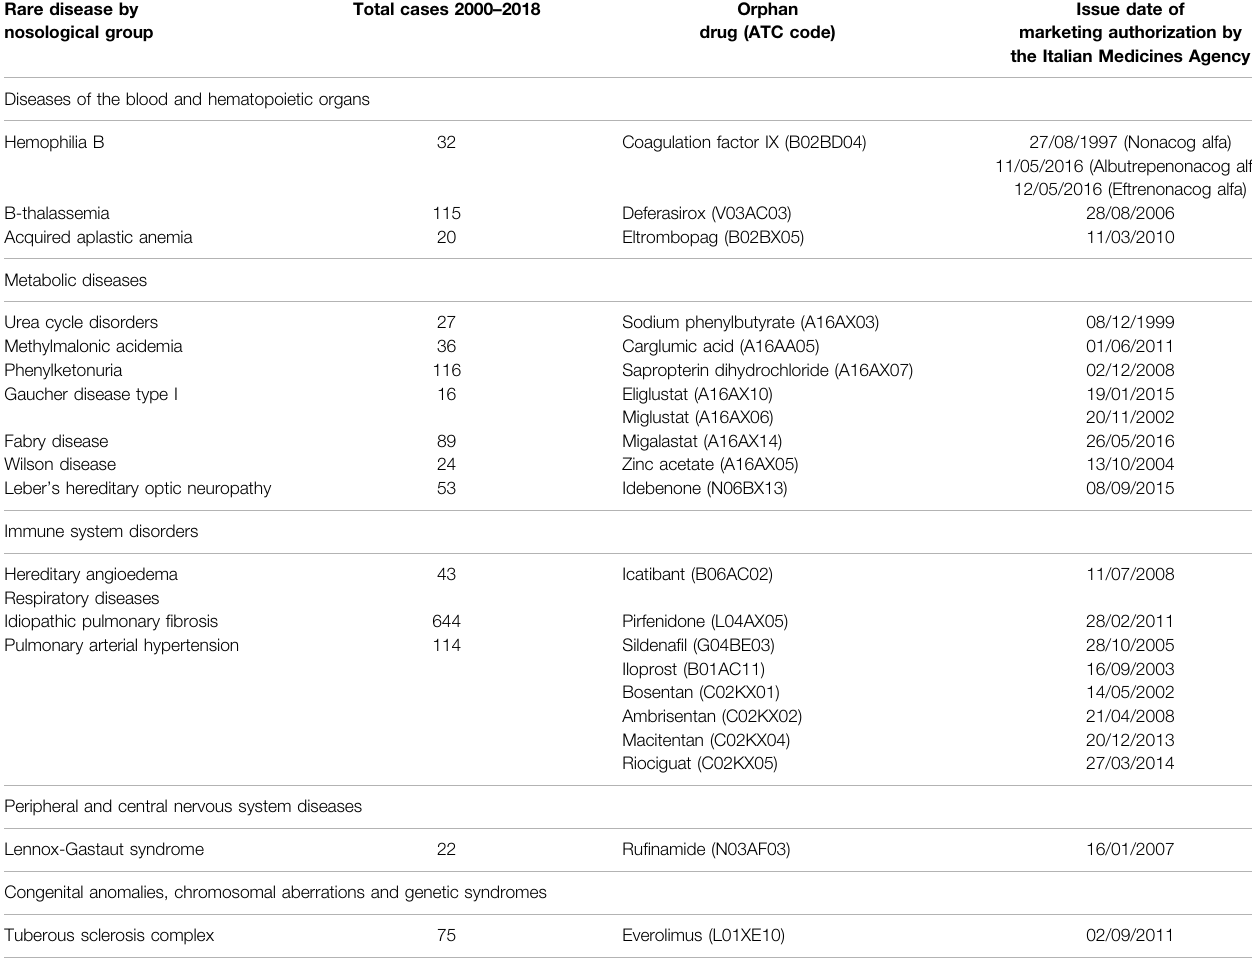
TABLE 1 | List of rare diseases and orphan drugs included in the